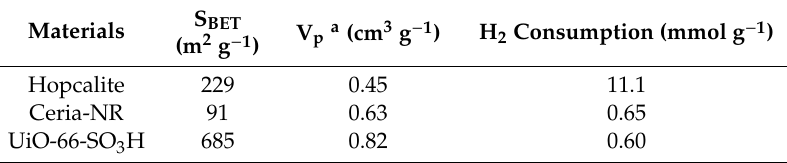
Figure 2. N 2 adsorption / desorption isotherms and PSD (inserts) of Hopcalite, Ceria-NR and UiO-66-SO 3 H. Table 1. Textural and redox properties of the